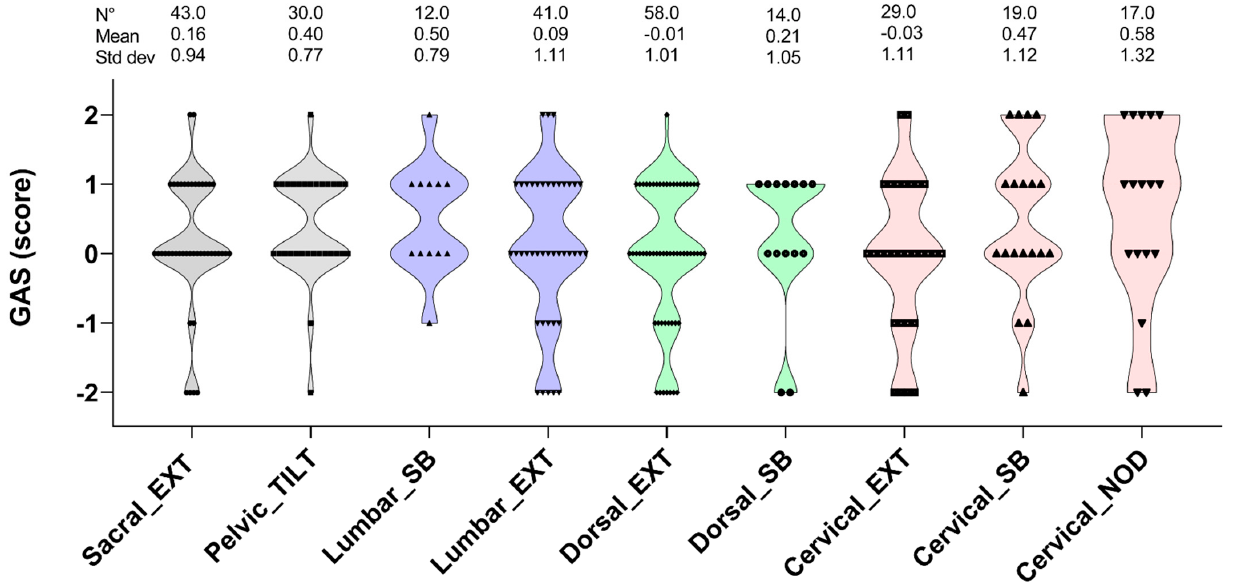
Figure 1. The violin plot graph shows the goal attainment scaling (GAS) scores of the spinal column mobility divided into sacral, pelvic, lumbar, dorsal, and cervical districts after 11 weeks of precision-based exercise plus osteopathic treatment. Only children, adolescents, and young adults with medium or high adherence to the training sessions and osteopathic treatments were considered (see the method section for further details). EXT, extension; SB, side bending, NOD, nodding.